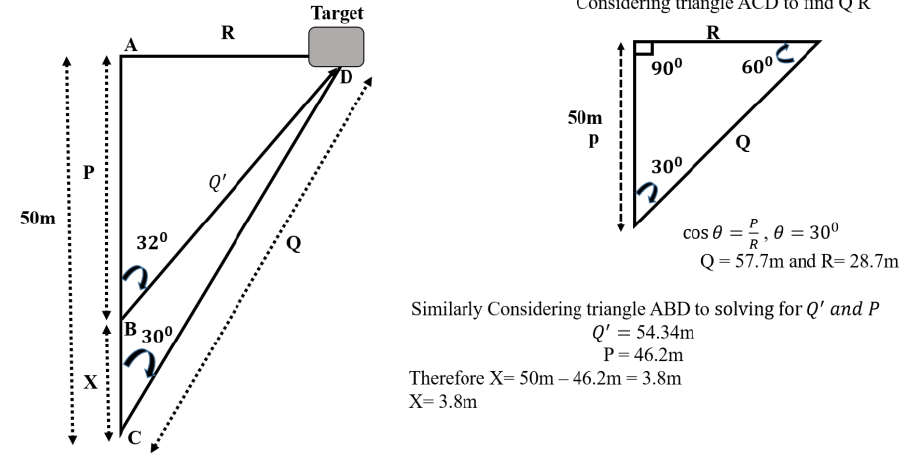
Figure 5. Representation of the analysis of the influence of the speed variation from min speed to max value.